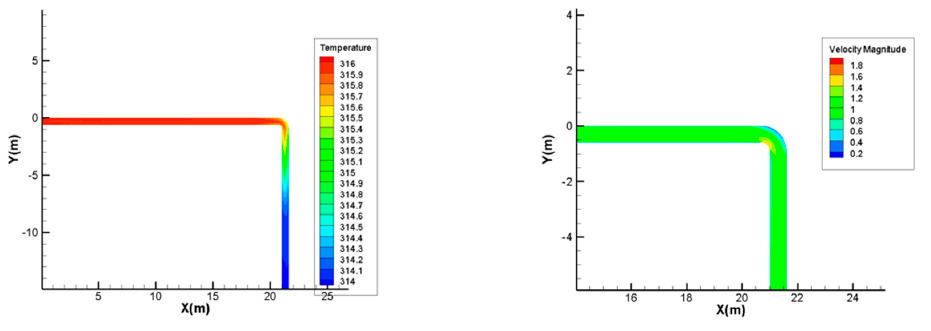
Figure 3. (a) Temperature contours and velocity contours under 1 million grids; (b) Temperature Figure 3. ( a ) Temperature contours and velocity contours under 1 million grids; ( b ) Temperature contours and velocity contours under 2 million grids; (c) Temperature contours and velocity contours and velocity contours under 2 million grids; ( c ) Temperature contours and velocity contours contours under 2.5 million grids; (d) Temperature contours and velocity contours under 4 million under 2.5 million grids; ( d ) Temperature contours and velocity contours under 4 million grids; ( e ) grids; (e) Temperature contours and velocity contours under 6 million grids. Temperature contours and velocity contours under 6 million grids.